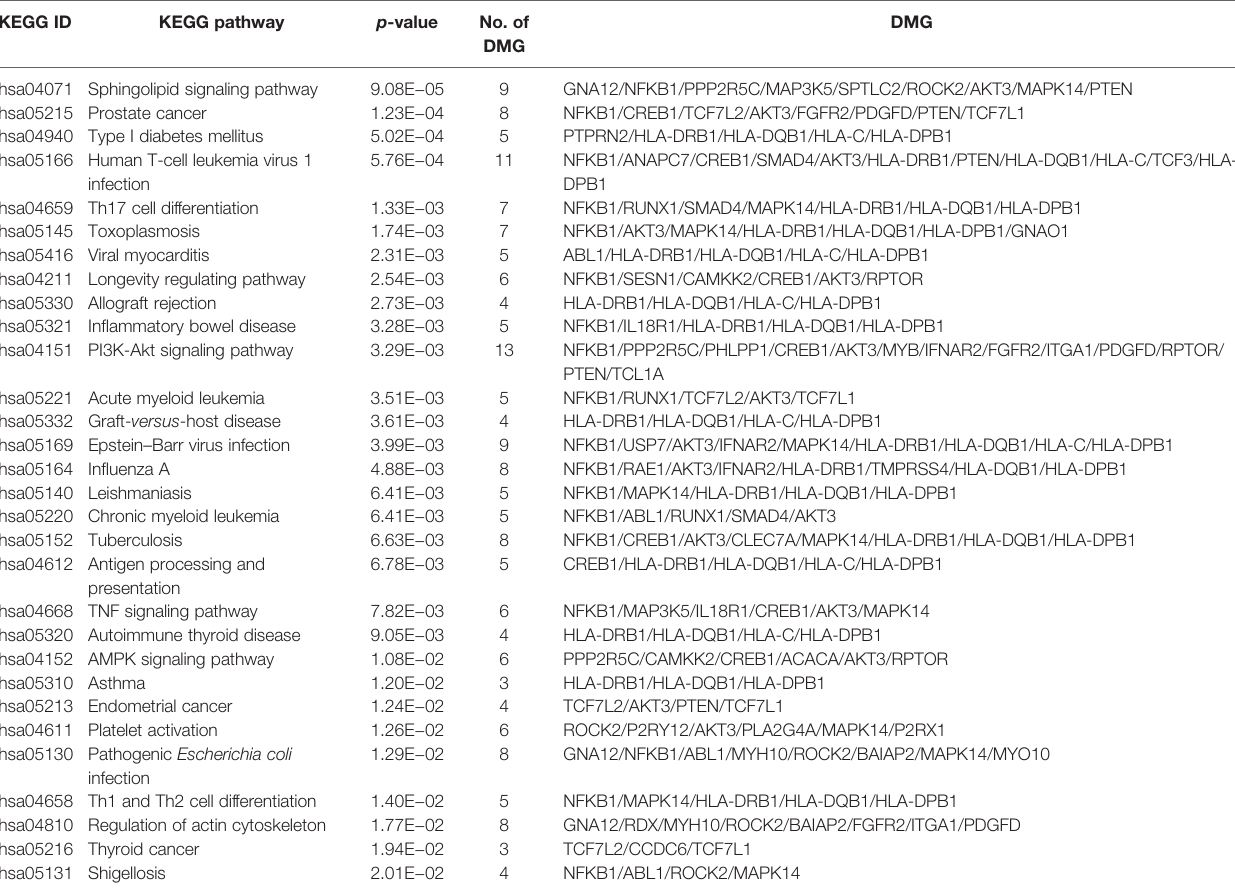
TABLE 5 | The top 30 prominently enriched KEGG pathways for the 304